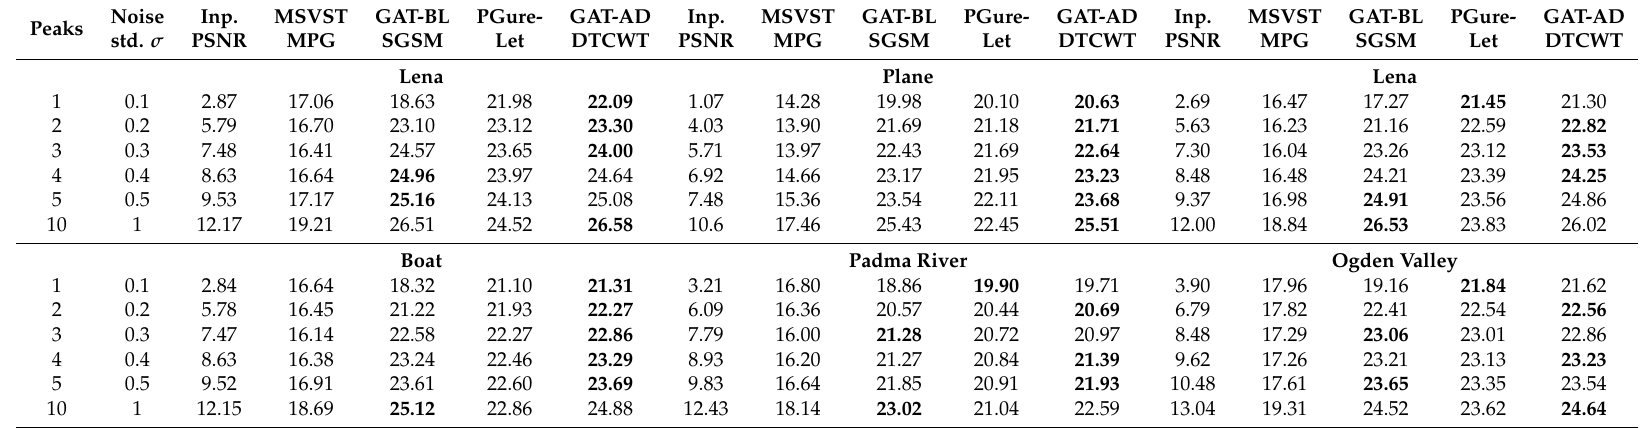
Table 2. Poisson–Gaussian denoising: Output PSNR value obtained from the proposed method and state-of-the-art comparative methods for input images at varying input PSNR levels (bold denotes highest